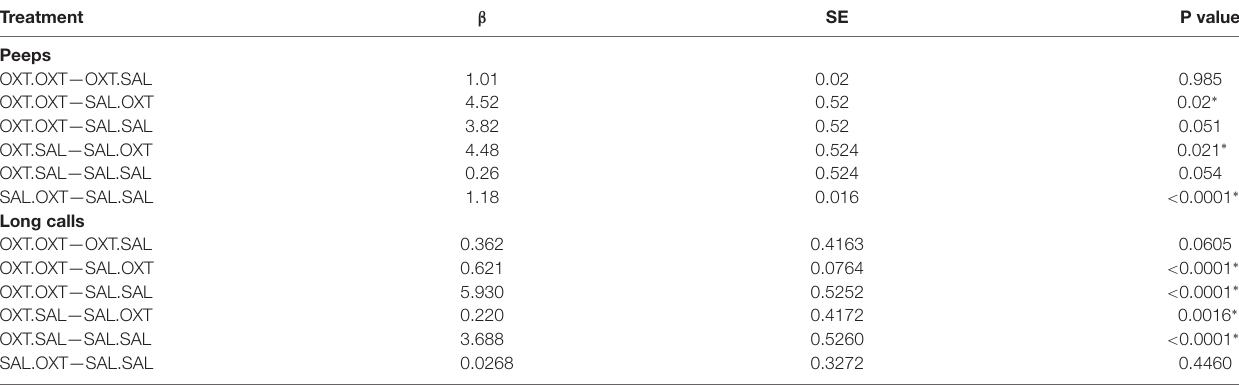
Supplementary Table S1 and Supplementary Table S1.1 for mean and SEs).